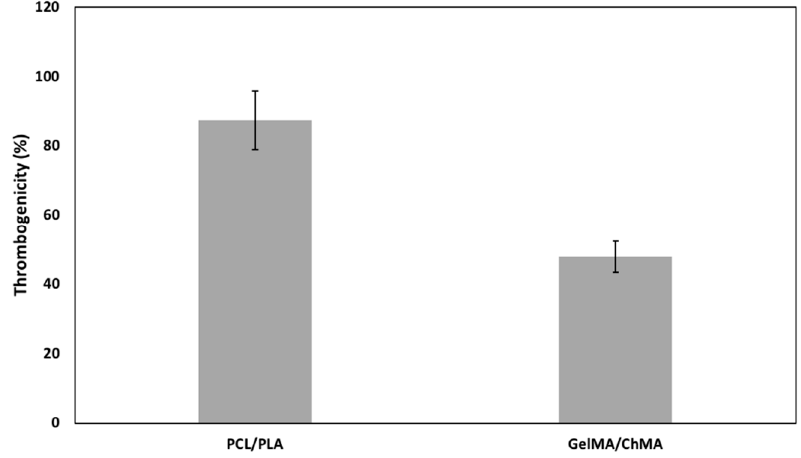
Figure 7. Percentage of thrombogenicity determined for each side of the asymmetric membrane after 40 min of contact with blood. Thrombogenicity was calculated and expressed as mean ± SME (n = 6).